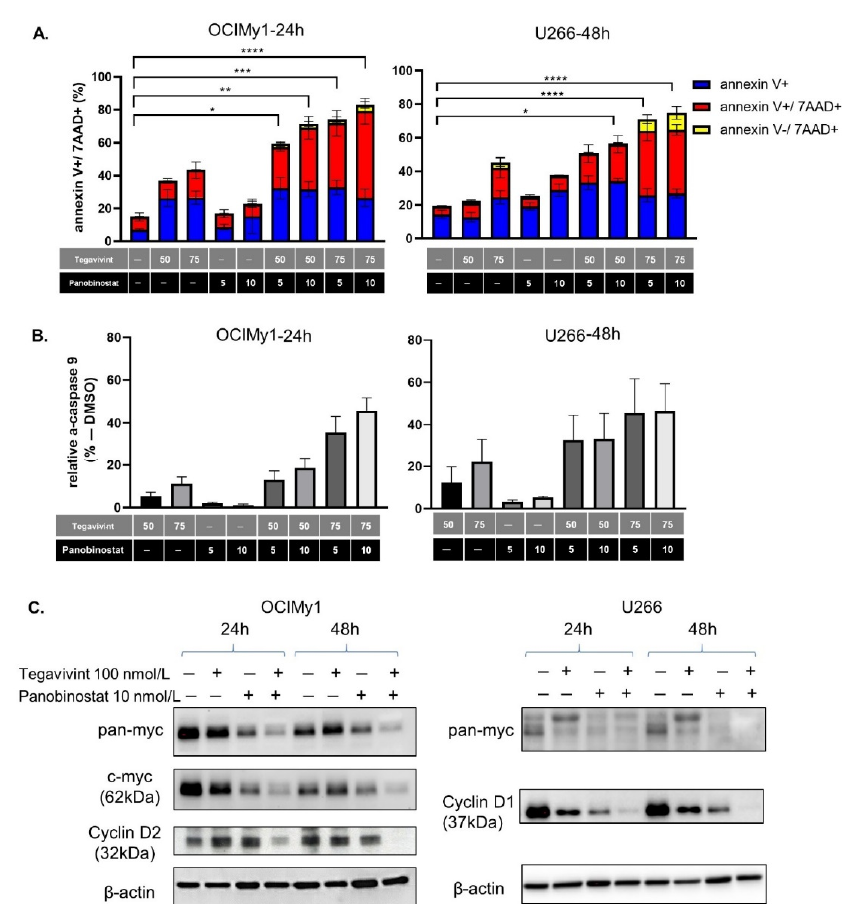
Figure 2. The combination of Tegavivint and panobinostat induces apoptotic cell death and down-regulation of β -catenin targets. ( A ) Percentage of annexin V, annexin V/7AAD, and 7AAD-positive cells after Tegavivint, panobinostat or the combination for OCIMy1 and U266 at 24 and 48 h respectively ( n = 3, ± SE). 2way ANOVA Dunett’s multiple comparisons test of row means to control row mean (DMSO treated) (* p = 0.0175, ** p = 0.0013, *** p = 0.0007, **** p < 0.0001 for OCIMy1 and * p = 0.0164, **** p < 0.0001 for U266). ( B ) Percentage of active caspase-9 after treatment with Tegavivint, panobinostat, or the combination for OCIMy1 and U266 at 24 and 48 h respectively relative to the vehicle (DMSO) treated cells ( n = 3, ± SE). ( C ) Immunoblotting of whole-cell lysates for β -catenin down-stream targets Myc, Cyclin D1 and Cyclin D2 after 24 or 48 h of treatment with Tegavivint, panobinostat, or the combination for OCiMy1 and U266. Loading control: β -actin ( n = 3). Detailed information about the Western blotting can be found at Figure